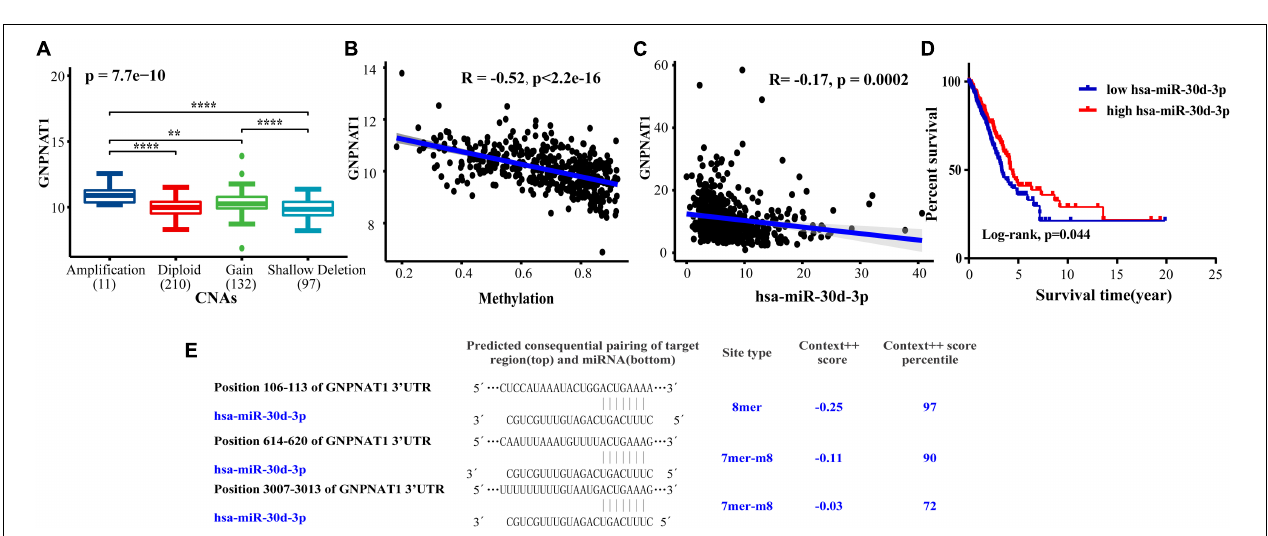
FIGURE 6 | The correlation between GNPNAT1 and some epigenetic factors. The association of GNPNAT1 with its DNA copy alternations (A) , methylation (B) , and has-miR-30d-3p expression (C) . (D) The KM curves of the correlation between has-miR-30d-3p expression and overall survival in LUAD based on TCGA data (Cutoff value of high/low group was the median of miRNA expression). (E) The predicted target region of GNPNAT1 and has-miR-30d-3p.